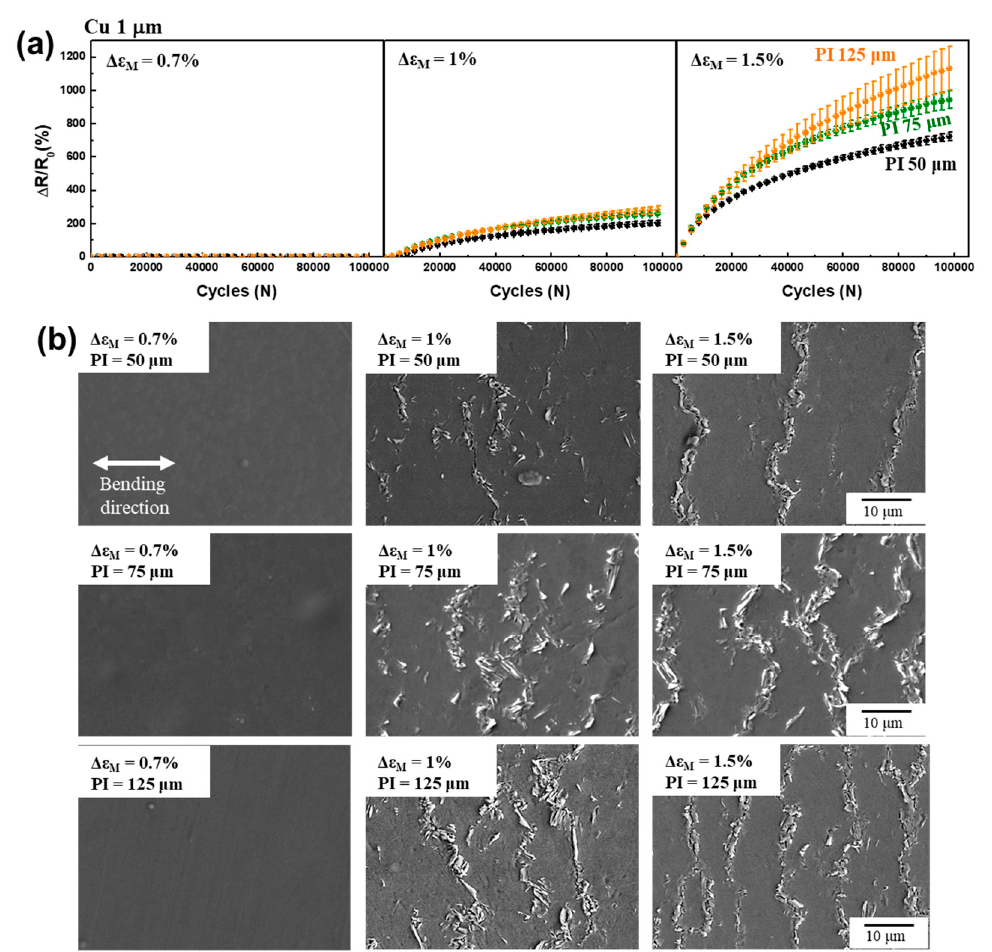
Figure 3. ( a ) Normalized electrical resistance changes of 1 µ m thick Cu film on 50, 75, and 125 µ m thick PI as a function of the number of bending cycles under bending strain amplitudes of 0.7%, 1%, and 1.5%. ( b ) SEM images of 1 µ m thick Cu film after the bending fatigue test.